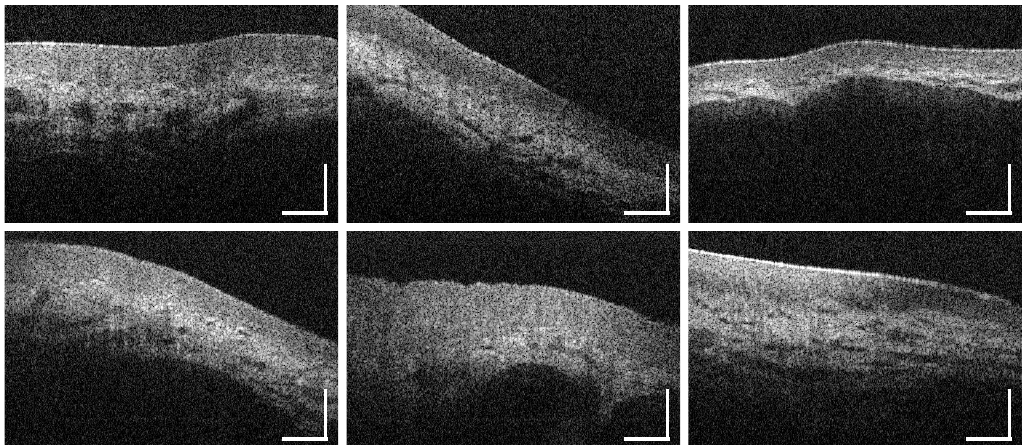
Figure A20. Supplementary intensity-based OCT cross sections of the oral mucosa of the central ventral tongue (MP10, Figure 1). Scale bars: 200 µ m.